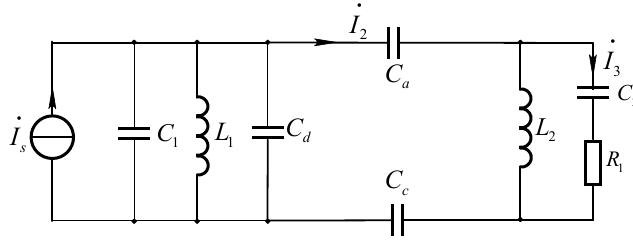
Figure 4. System circuit diagram after Norton change.